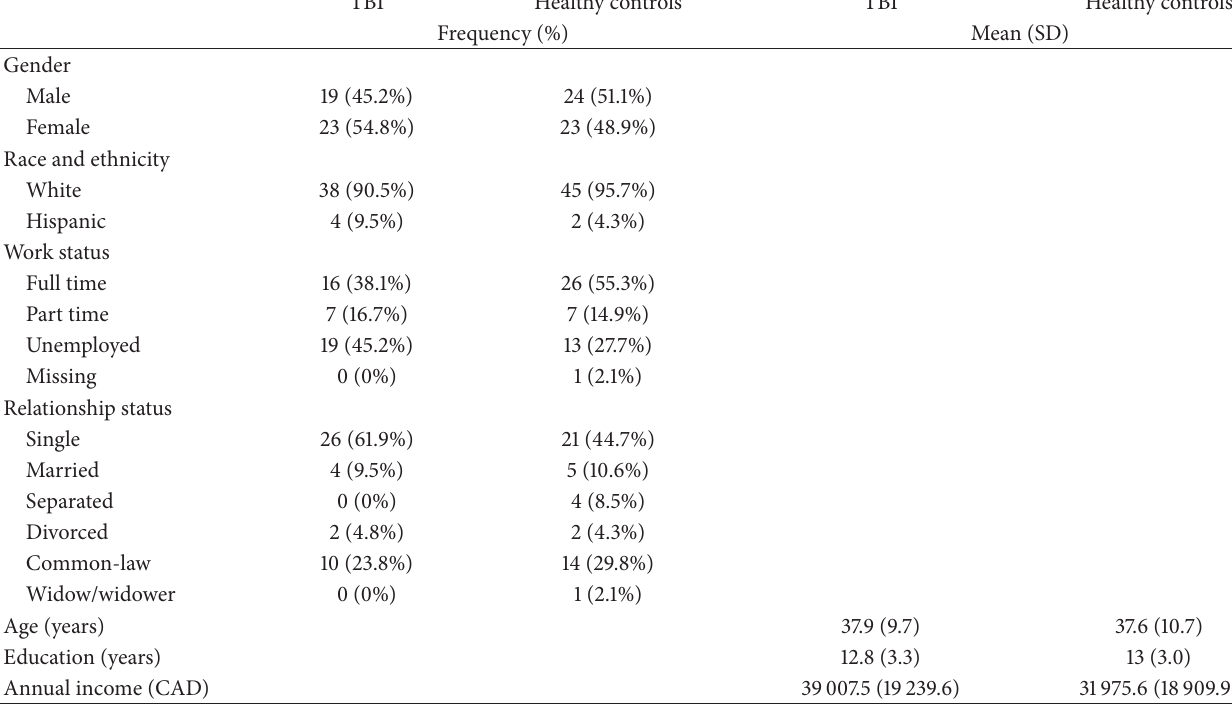
Table 1: Sociodemographic characteristics of the TBI and healthy control samples ( 𝑁 = 89